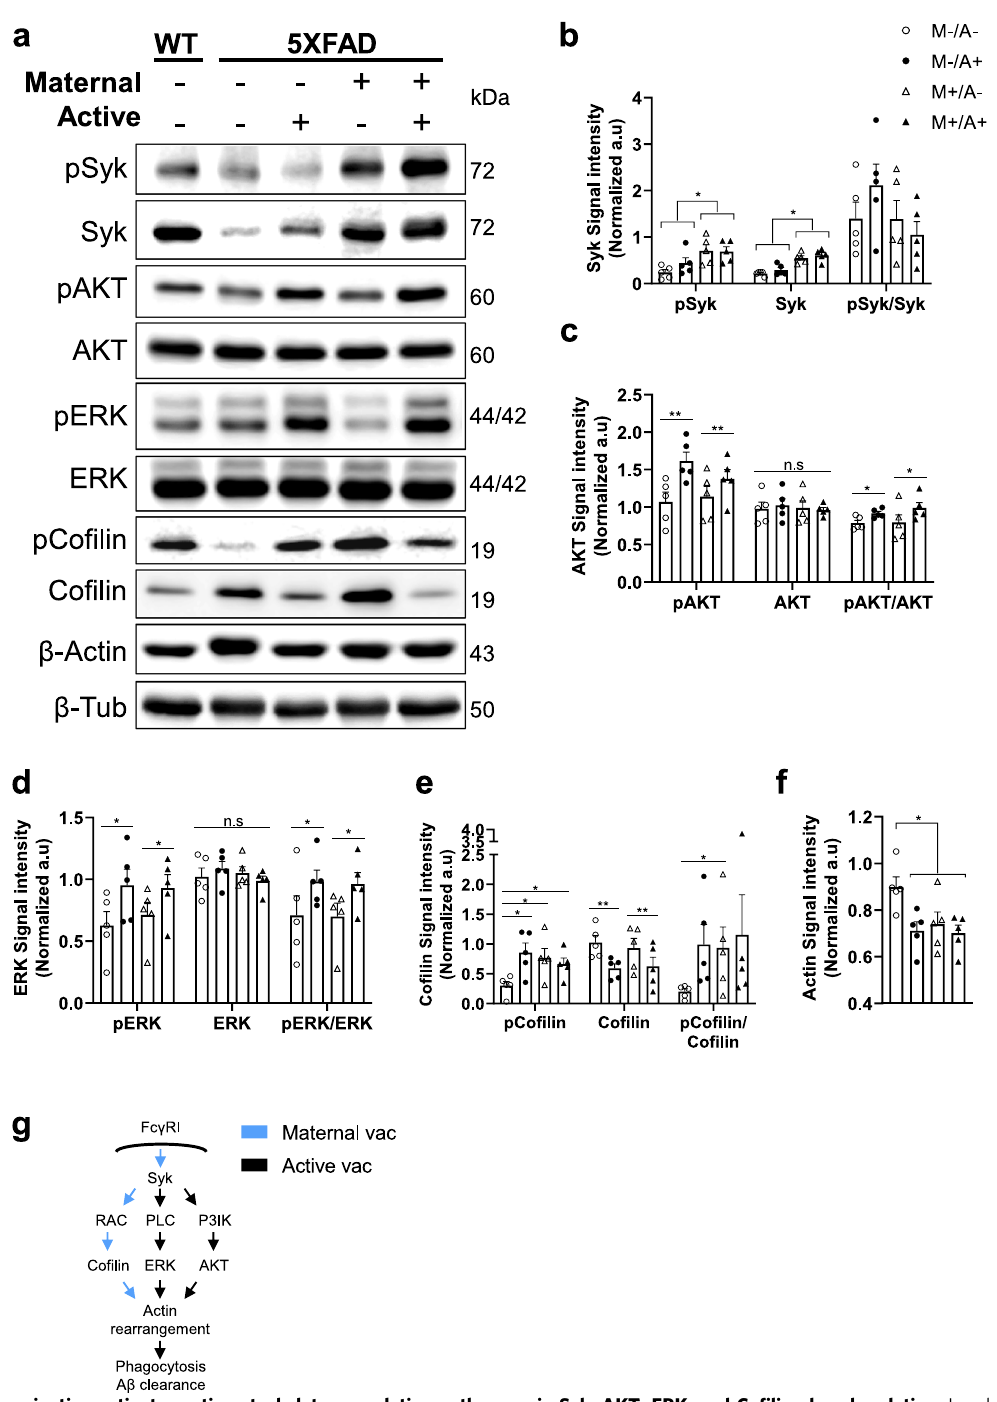
Fig. 7 Maternal vaccination activates actin-cytoskeleton regulation pathways via Syk, AKT, ERK, and Co fi lin phosphorylation. Level of Syk and downstream signaling molecules from the Fc-mediated phagocytosis pathway were measured using immunoblotting following maternal and active vaccination at 5 m of age ( n = 5 ). Levels of ( a , b ) pSyk/Syk, ( a , c ) pAKT/AKT, ( a , d ) pERK/ERK, ( a , e ) pCo fi lin/Co fi lin, and ( a , f ) Actin levels, normalized to tubulin. g Maternal and active vaccinations activate Fc γ R-mediated phagocytosis pathways through actin cytoskeleton regulation. * P < 0.05, ** P < 0.01, two-way ANOVA, data are presented as mean ±